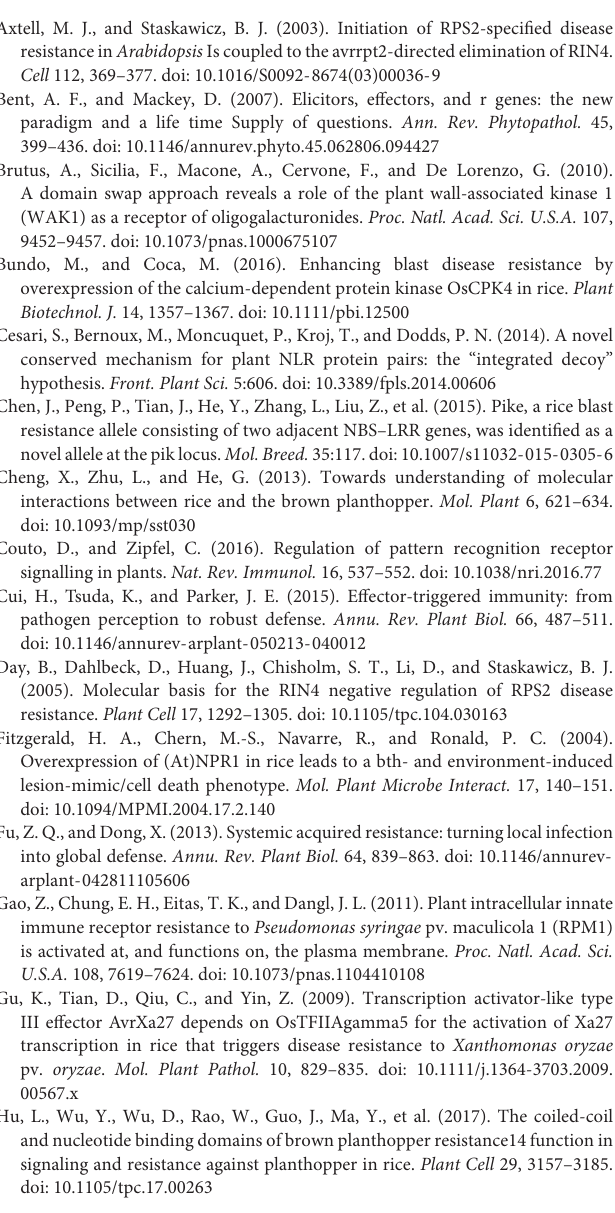
TABLE S1 | Segregation analysis of T 1 AtRPS2 transgenic plants. TABLE S2 | Segregation analysis of T 1 AtRPM1 ( D505V ) transgenic plants. TABLE S3 | Differentially expressed genes (DEGs) between Nipponbare and AtRPS2 transgenic plants. TABLE S4 | Differentially expressed genes (DEGs) between Nipponbare and AtRPM1 ( D505V ) transgenic plants. TABLE S5 | Co-regulated genes in AtRPS2 and AtRPM1 ( D505V ) transgenic plants. TABLE S6 | List of qRT-PCR primers used in this